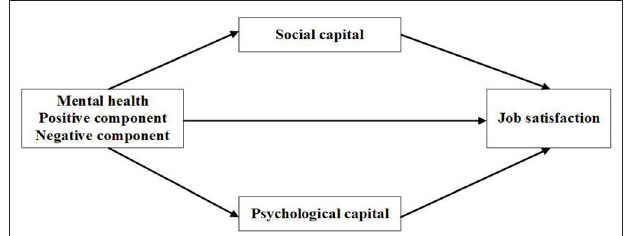
FIGURE 1 | The theoretical